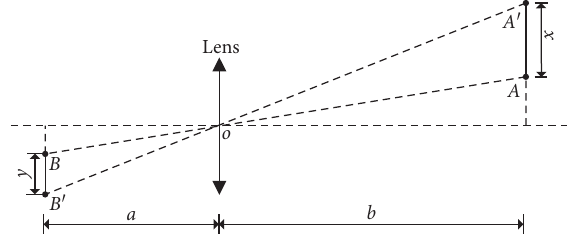
Figure 3: The principle of vision-measurement